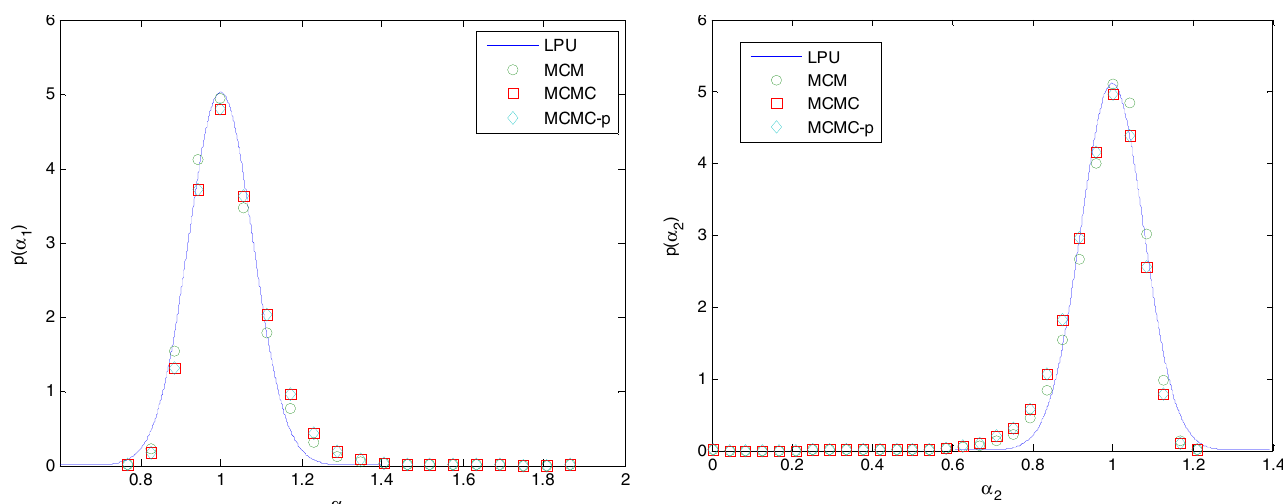
Fig. 2. Four distributions associated with the parameter α 2 .